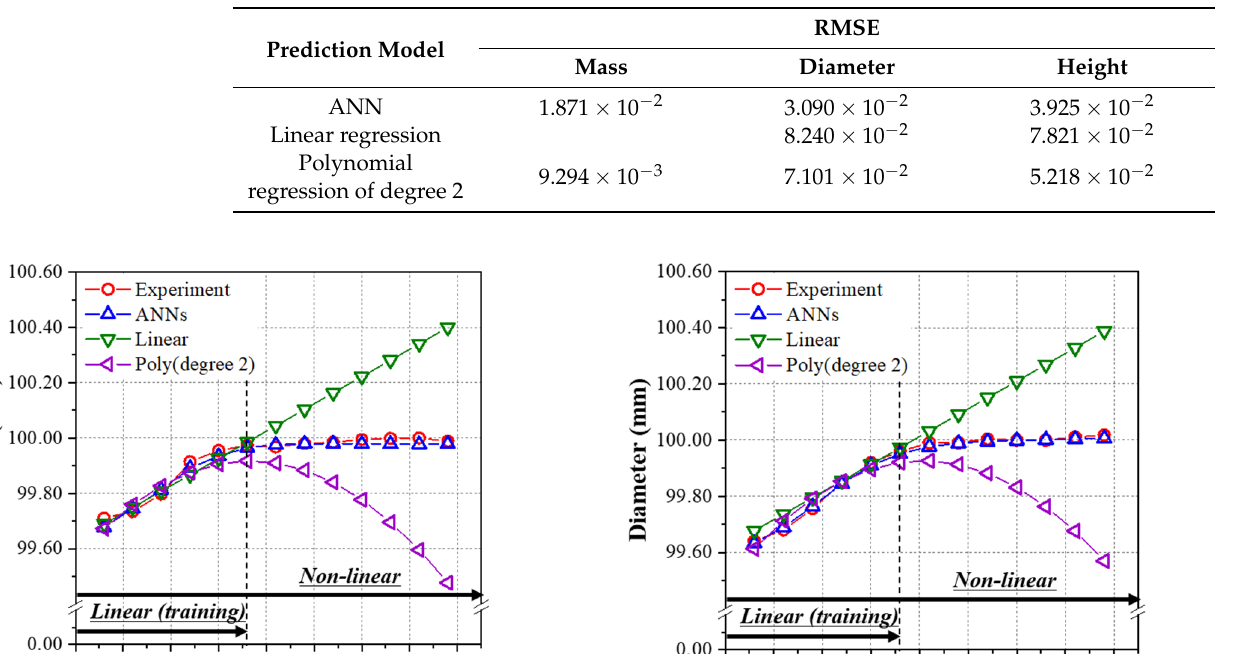
Table 10. Root mean square errors (RMSEs) of normalized Table A2 (packing time was 3.0~18.0 s) for prediction models learned by the linear relation group (packing time was 3.0~18.0 s).